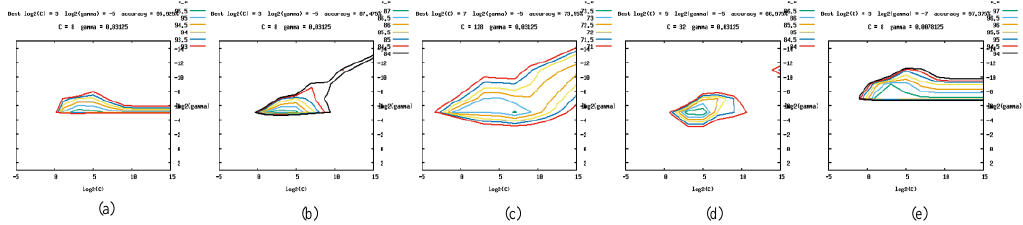
Figure 3. Parameter optimization figures under different feature fusion operation in the LivDet 2011 dataset from Digital: ( a ) addition operation; ( b ) maximum operation; ( c ) minimum operation; ( d ) average operation; ( e ) concatenation operation.